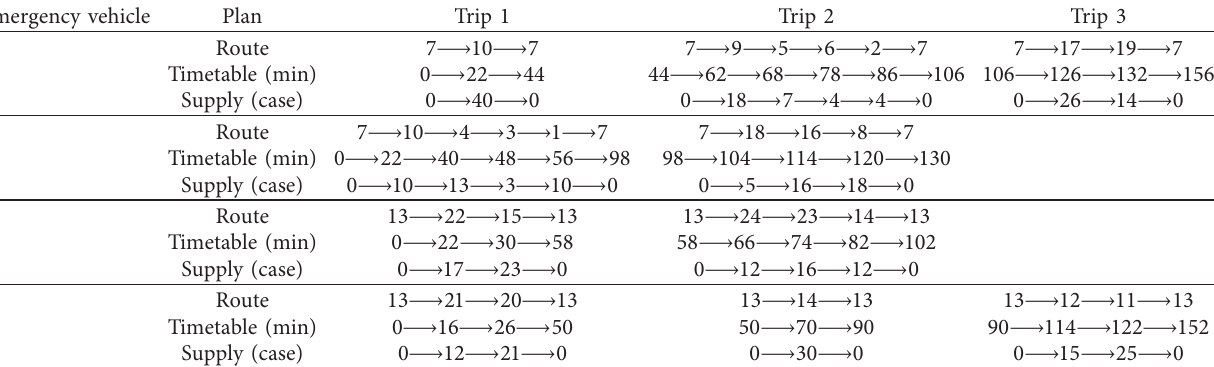
Table 3: Optimal model of the emergency supply distribution plan.